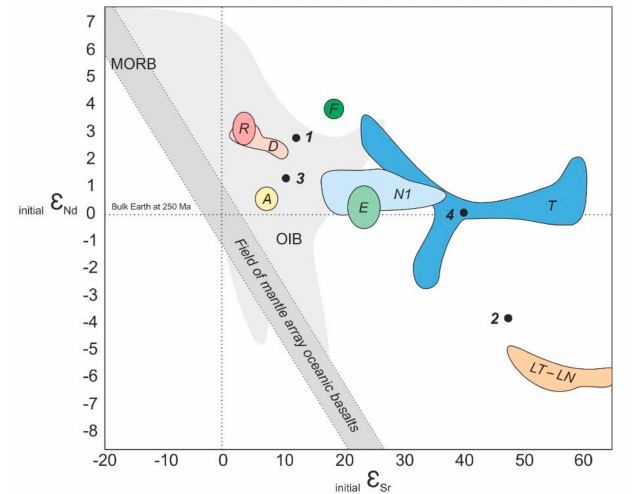
Figure 20. Initial ε Nd– ε Sr plot for the Siberian intrusive